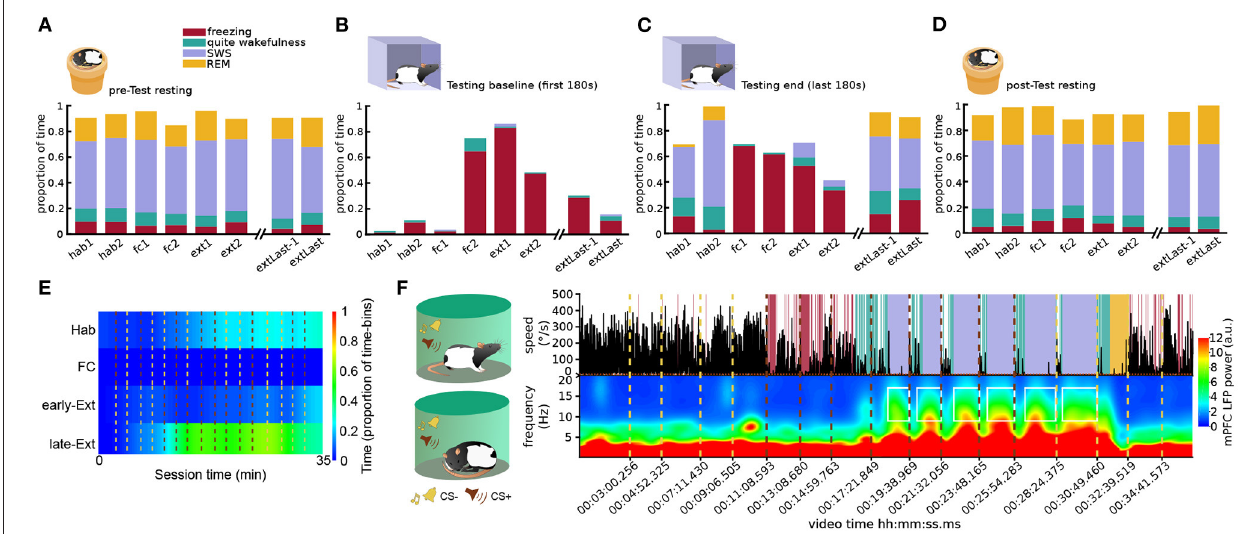
FIGURE 3 | Scoring pipeline performance on a multi-day fear conditioning and extinction protocol. (A) Average time classified SWS, REM, quiet wakefulness, and freezing during the rest sessions before exposure to the testing environments for each day of the behavioral protocol. (B) Same as (A) but for the first 3 min in the conditioning context A. (C) Same as (A) but for the last 3 min in the conditioning context A. (D) Same as (A) but for rest sessions following exposure to the testing environments. (E) Average time spent sleeping across auditory cued extinction training sessions in context B for all animals; red dashed vertical lines: CS+ onsets; ochre dashed vertical lines: CS − onsets. (F) State scoring in a representative session of late extinction of cued fear involving both sleep and freezing (see Supplementary Video 5 ). (Top) Animal speed as measured by head movements; red dashed vertical lines: CS+ onsets; ochre dashed vertical lines: CS − onsets. Time stamps of CSs presentations corresponding to those overlaid in Supplementary Video 5 frames are indicated below the plots. Shaded area: periods classified as freezing (red), quiet wakefulness (green), SWS (blue), and REM (yellow). Note how the animal did not freeze during CS − presentations, but the onsets of the first three CS+ triggered freezing responses. (Bottom) Spectrogram of mPFC LFP activity; white squares: intervals of elevated sleep spindle power scored as SWS. The rat started to sleep after the fourth CS+ presentation and from then on, every CS+ presentation woke him up, but he fell asleep again within 30–40